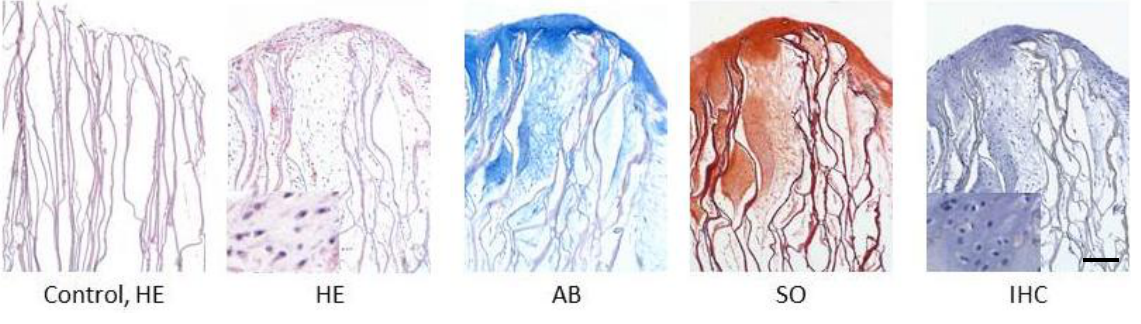
Figure 5. Histological analysis of the SF scaffold-chondrocytes constructs after eight weeks of in vitro culture (bar = 150 µm). HE, hematoxylin and eosin; AB, Alcian blue; SO, Safranin O; IHC, immunohistochemical stain of collagen Type II. The control is the acellular SF